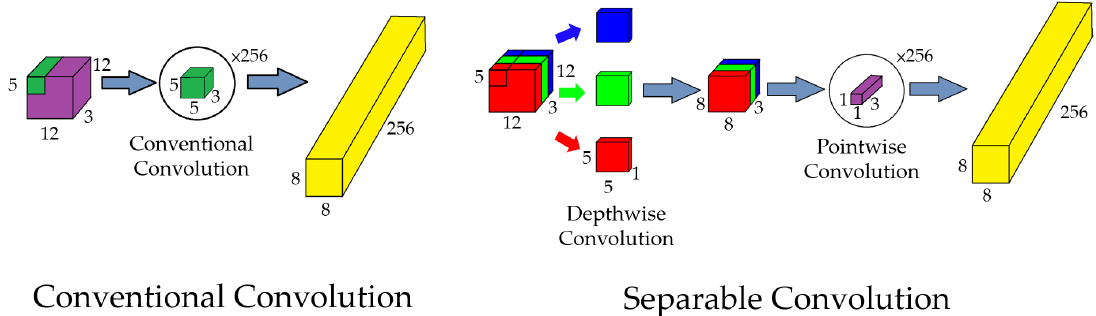
Figure 3. Conventional convolution and separable convolution.